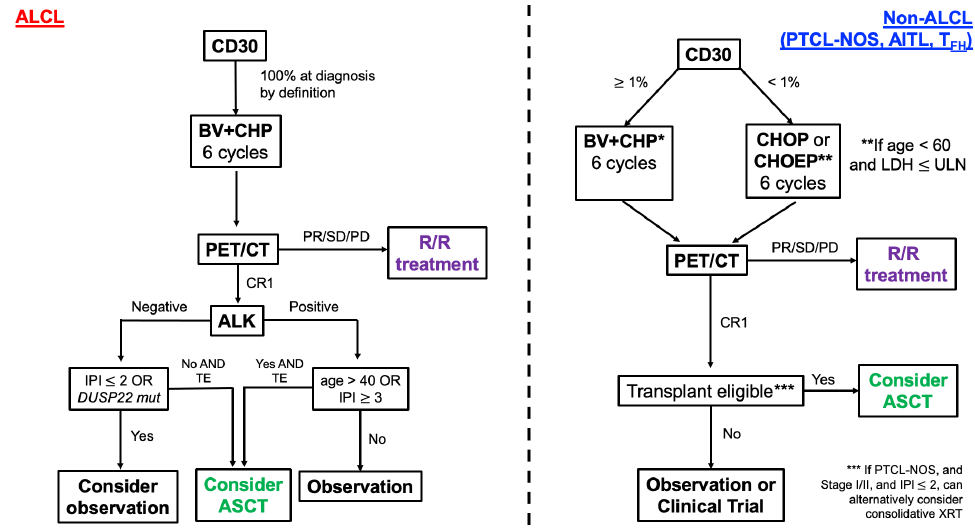
Figure 1. Suggested algorithm for frontline treatment of anaplastic large cell lymphoma (ALCL) and the most common non-ALCL peripheral T-cell lymphoma (PTCL) subsets. CD30 expression should be determined based on tissue biopsy immunohistochemistry analysis. LDH = lactate dehydrogenase, ULN = upper limit of normal, BV + CHP = brentuximab vedotin, cyclophosphamide, doxorubicin, prednisone, CHOP = cyclophosphamide, doxorubicin, vincristine, prednisone, CHO(E)P = cyclophosphamide, doxorubicin, vincristine, etoposide, prednisone, PET/CT = positron emission tomography/computed tomography, PR = partial response, SD = stable disease, PD = progressive disease, CR1 = complete response #1, IPI = international prognostic index, ASCT = autologous stem cell transplant, R/R = relapsed and/or refractory, TE = transplant eligible, XRT = radiotherapy, ALK, DUSP22. * While the authors favor BV + CHP for patients with CD30 expression ≥ 1%, CHOP or CHOEP for non-ALCL PTCL can be